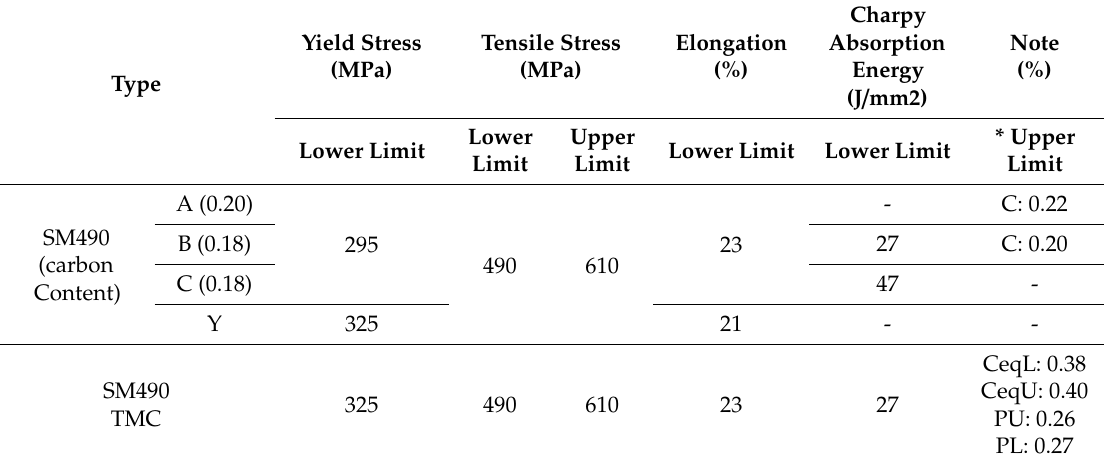
Table 1. Properties of grade 490